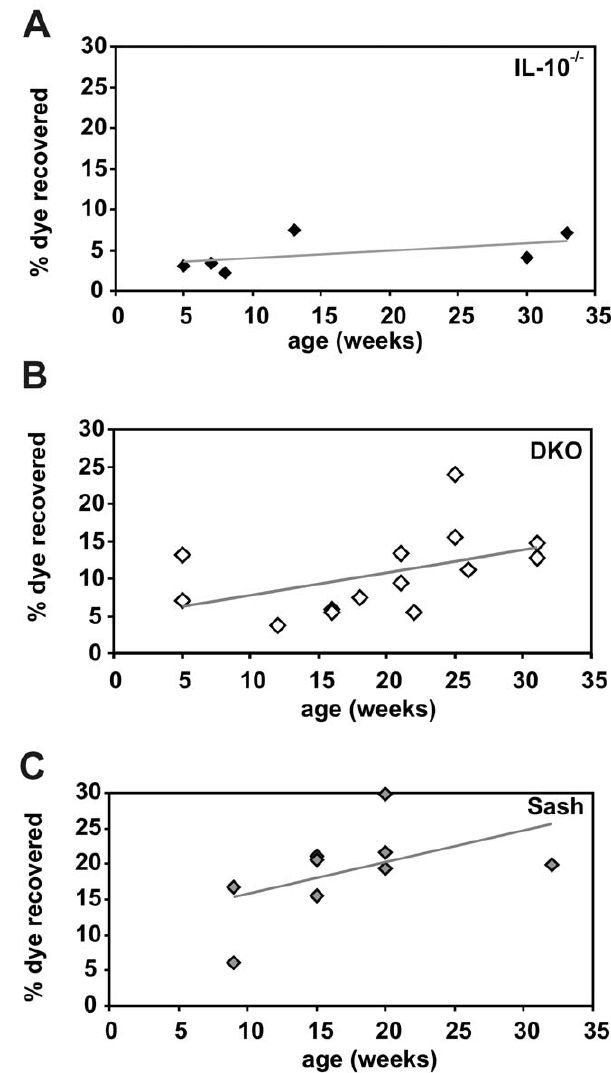
Figure 8. Permeability of the intestinal barrier in IL-10 2 / 2 and DKO mice. Mice of the indicated ages and genotypes were gavaged with phenol red and the amount of dye absorbed was determined by spectrophotometric measurement of urine. Each point shown repre- sents the average of 2–4 mice tested in a single experiment. Mast cell- deficient DKO and sash mice had significantly increased dye recovery compared with Il10 2 / 2 mice (p=0.02 for differences in data point elevation via linear regression analysis). The total numbers of mice tested were: Il10 2 / 2 (n=14), DKO (n=18), and sash (n=22).